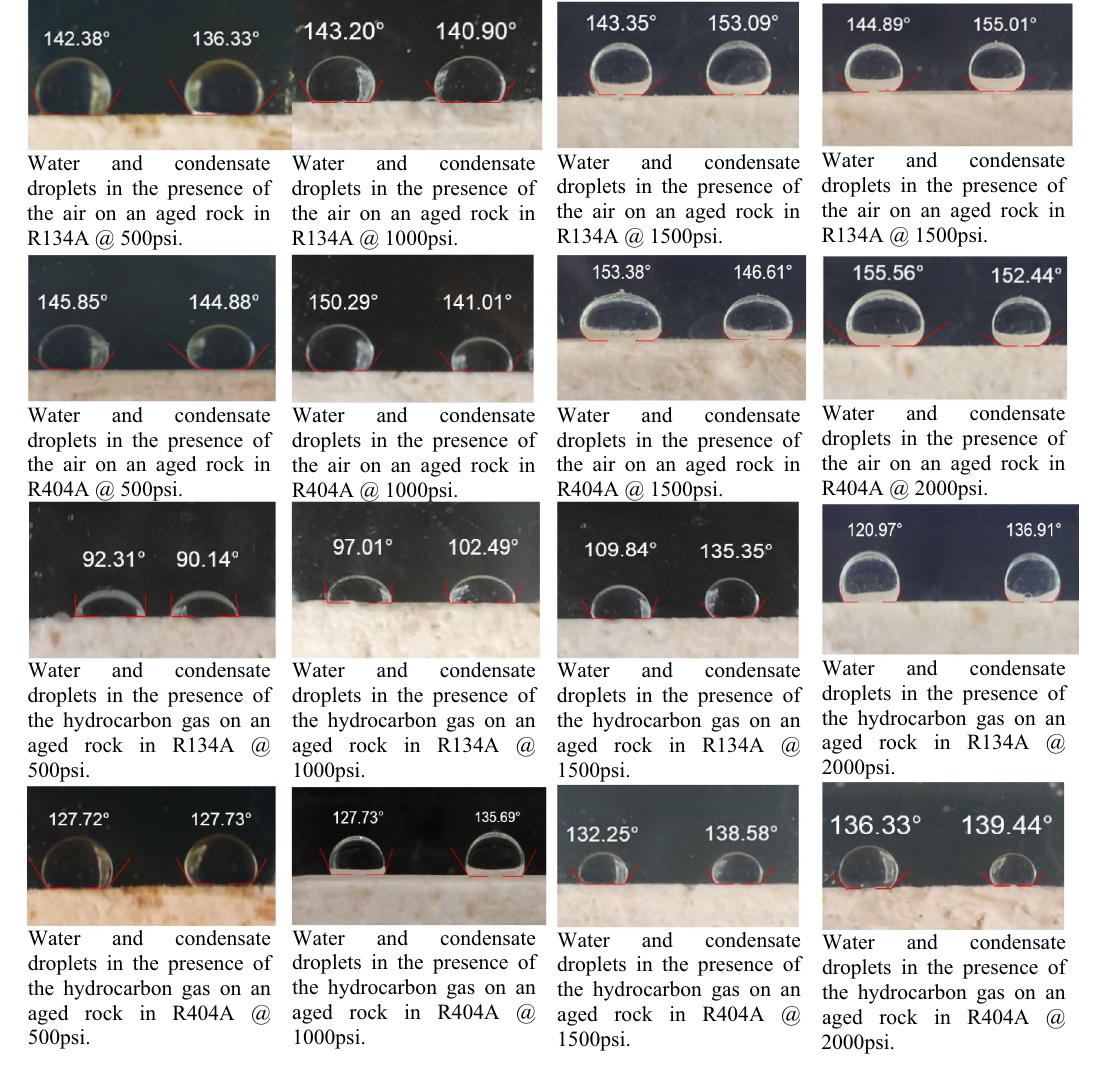
Fig. 10 Images of water and condensate droplets in the presence of the air and hydrocarbon gas on aged carbonate sections in R134A and R404A gases at a constant temperature of 70 °C, different pressures,